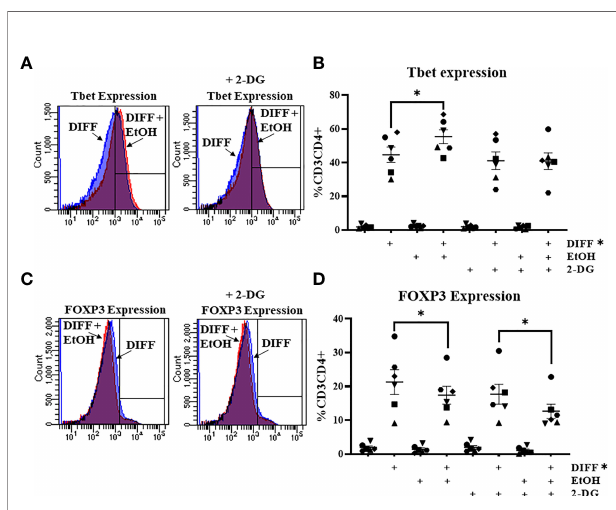
FIGURE 4 | Effect of 2-deoxyglucose (2-DG) on CD4 + T cells. (A) Representative FACS histograms plots of Tbet expression in DIFF, DIFF + EtOH, and DIFF+ EtOH + 2-DG CD4 + T cells. (B) The addition of 0.5 mM 2- deoxyglucose (2-DG) prevents the ethanol-mediated increase of Tbet- expressing CD4 + T cells. (C) Representative FACS histograms plots of FOXP3 expression in DIFF, DIFF + EtOH, and DIFF+ EtOH + 2-DG CD4 + T cells. (D) The addition of 0.5 mM 2-deoxyglucose (2-DG) did not alter the ethanol-mediated decrease of FOXP3-expressing CD4 + T cells. Naïve = undifferentiated and no ethanol treatment, EtOH = undifferentiated and ethanol-treated, DIFF = differentiated and no ethanol treatment, and DIFF + EtOH = differentiated and ethanol-treated. Data represents average values using CD4 + T cells from 6 donors expressed as mean ± SEM. Signi fi cant differences (p<0.05) were determined by repeated measures 3-way ANOVA. Post- hoc analysis was done using Sidaks multiple comparison test. *p ≤